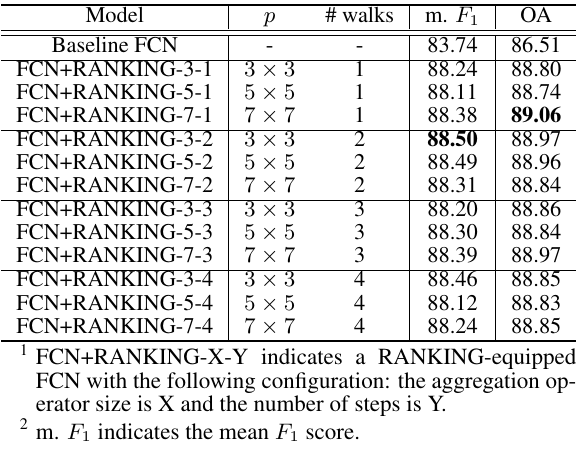
Table 1. Ablation Study on the Vaihingen Dataset.